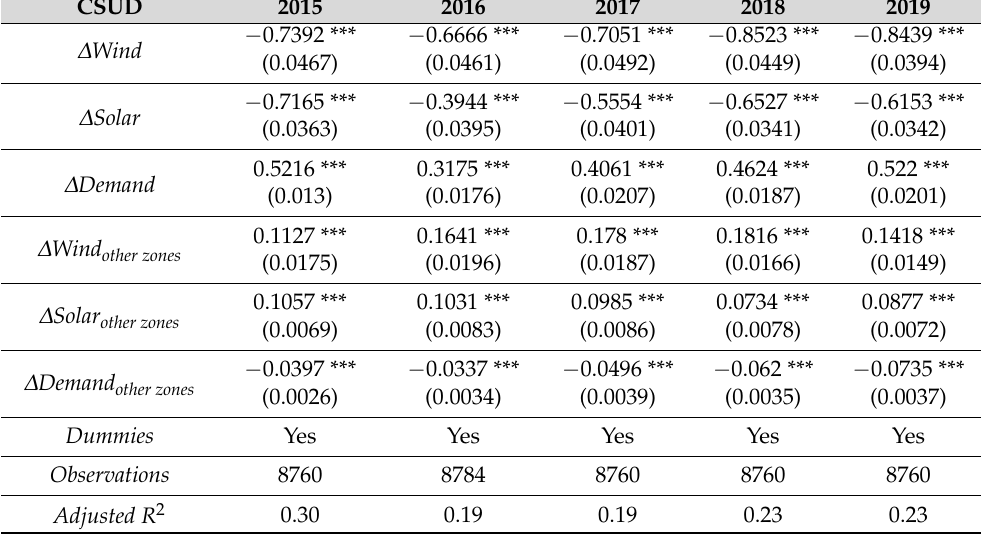
Table A8. OLS estimation of hourly changes in net input flow of CSUD; results of Equation (1). CSUD